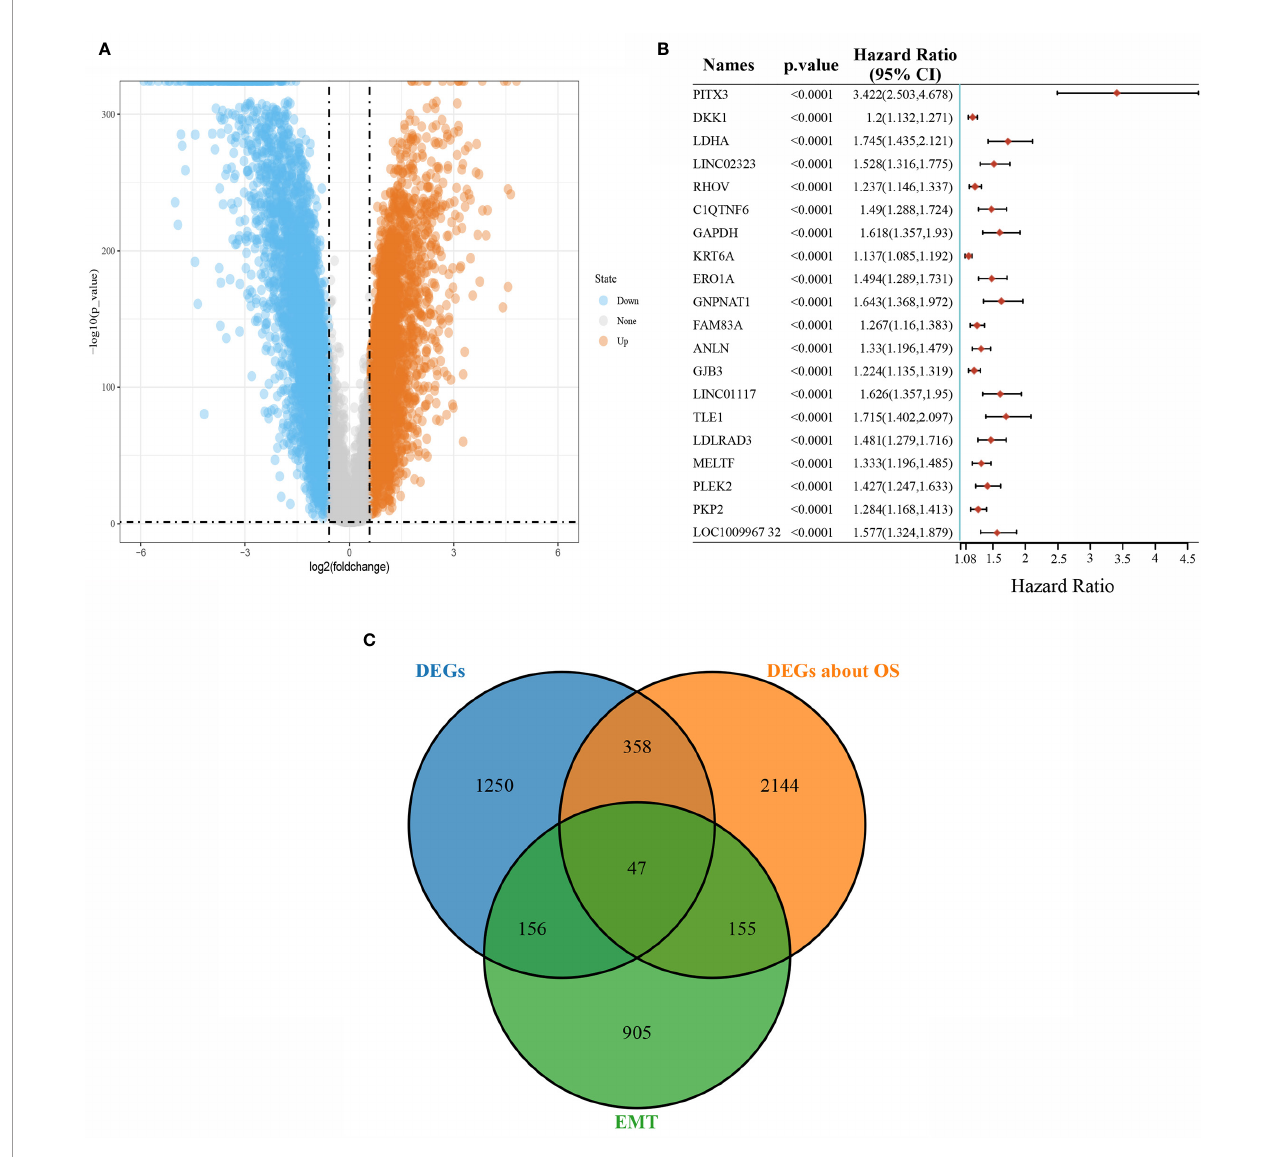
FIGURE 1 | Screening of differentially expressed genes. (A) Volcano plot showing differentially expressed genes in LUAD; (B) The top 20 total survival-related genes in LUAD; (C) Venn diagram of differentially expressed, survival-related, and EMT-related overlapping